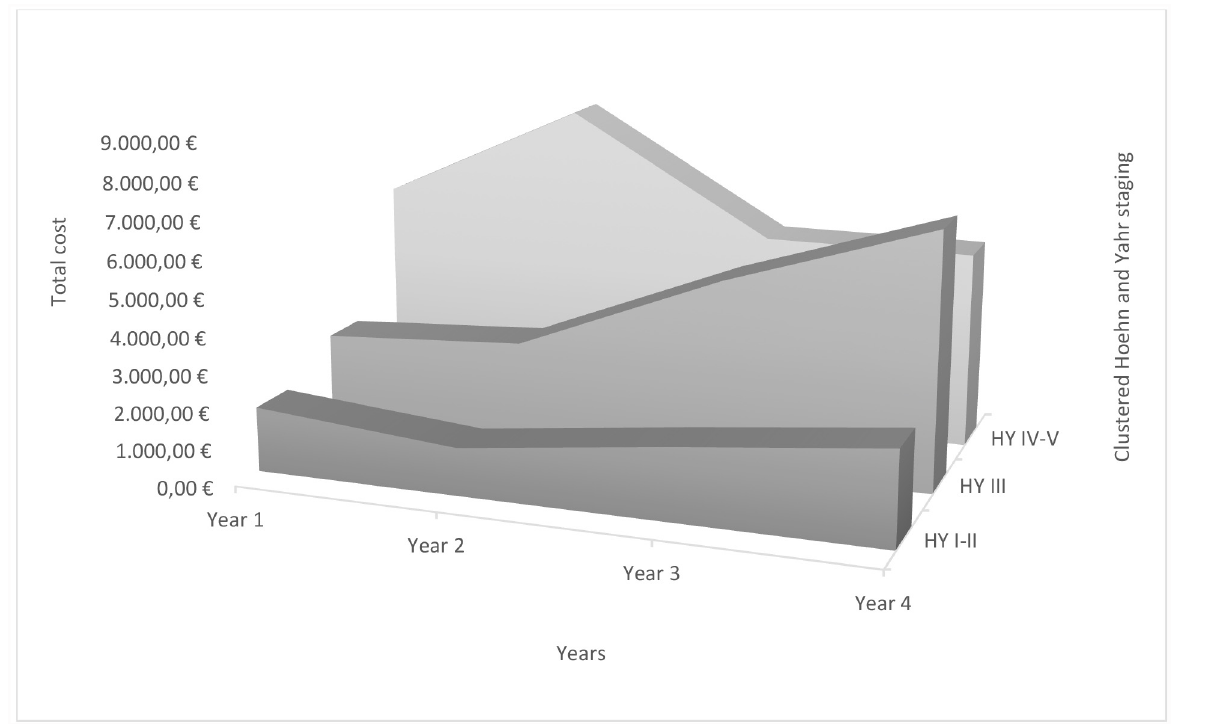
Fig 2. Total costs due to disease progression — disease severity according to clustered Hoehn and Yahr